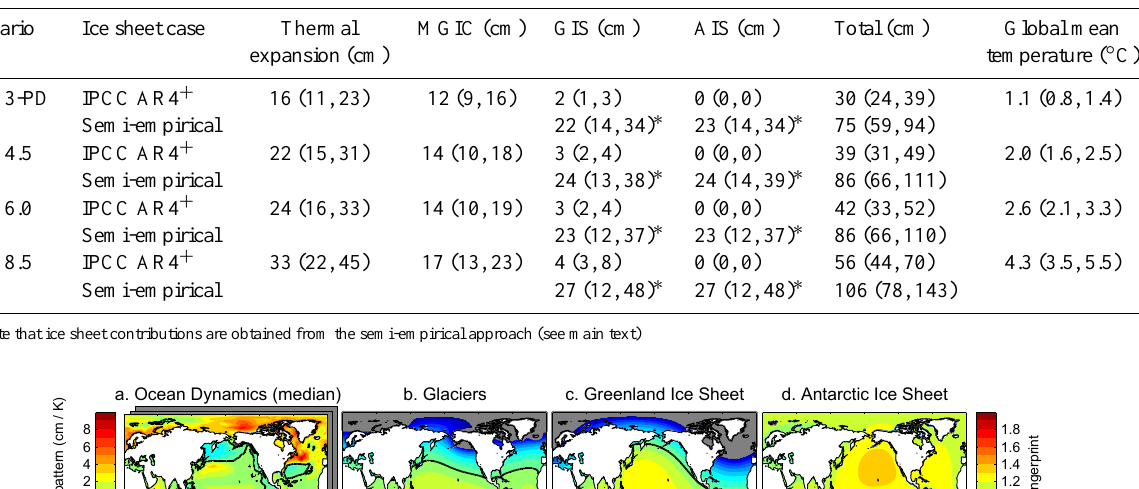
Table 3. Global mean projected contributions between 1980–1999 and 2090–2099 periods. Brackets indicate the “likely” range (roughly the 16th and 84th percentiles). The unit is centimetre or degree Celsius. All numbers are rounded. Note that mountain glaciers and ice caps (MGIC) include those present at Greenland margins and on the Antarctic Peninsula.